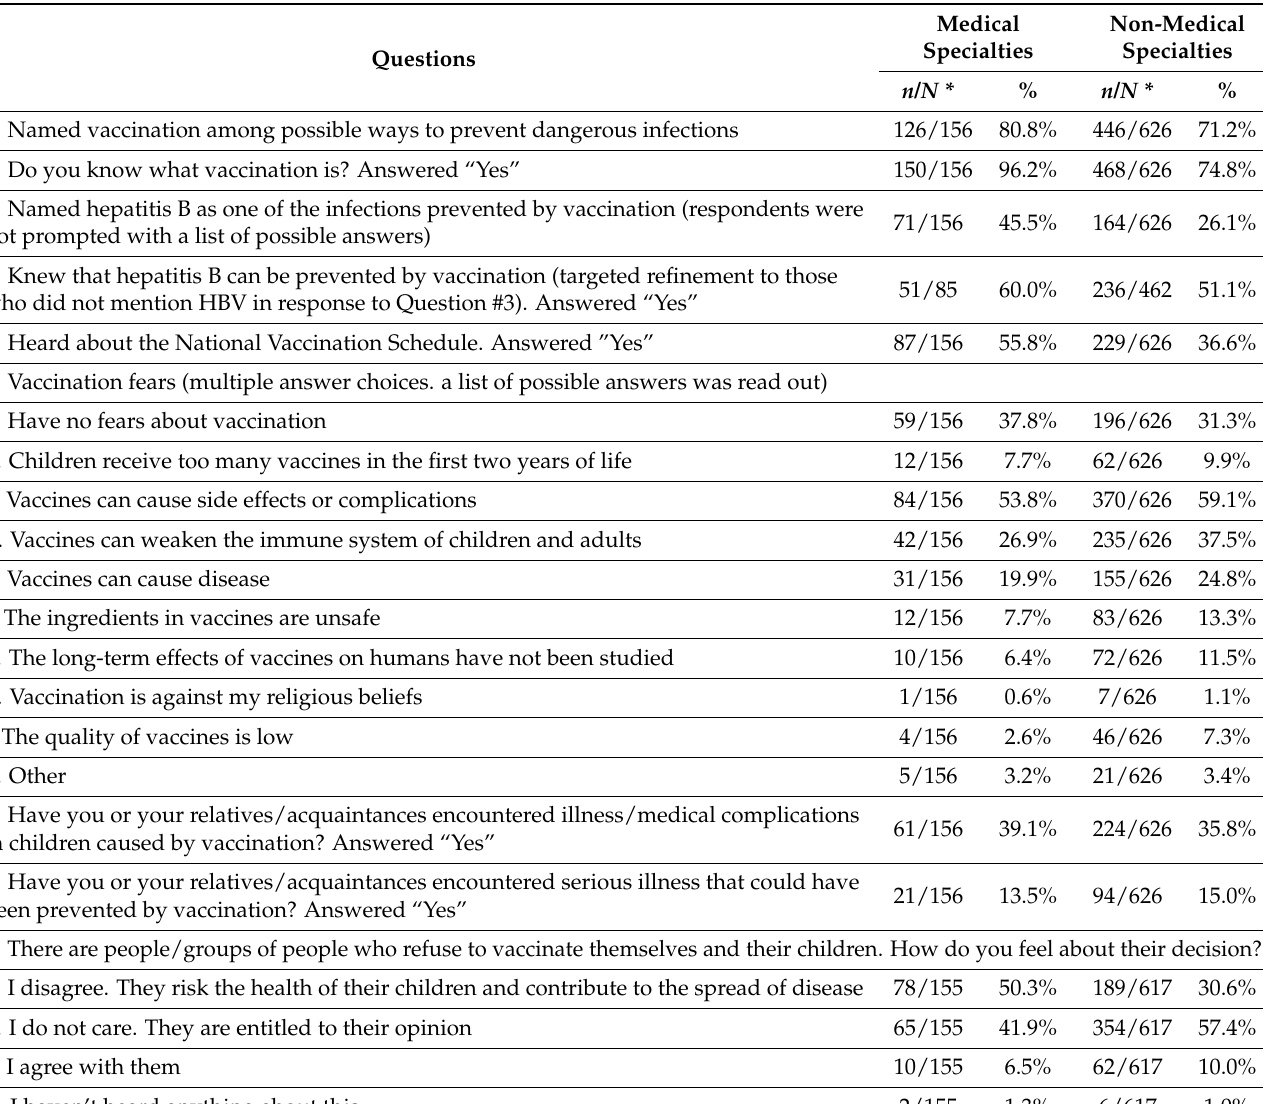
Table 3. Knowledge of and attitude towards vaccination expressed by university students and teachers of medical and non-medical